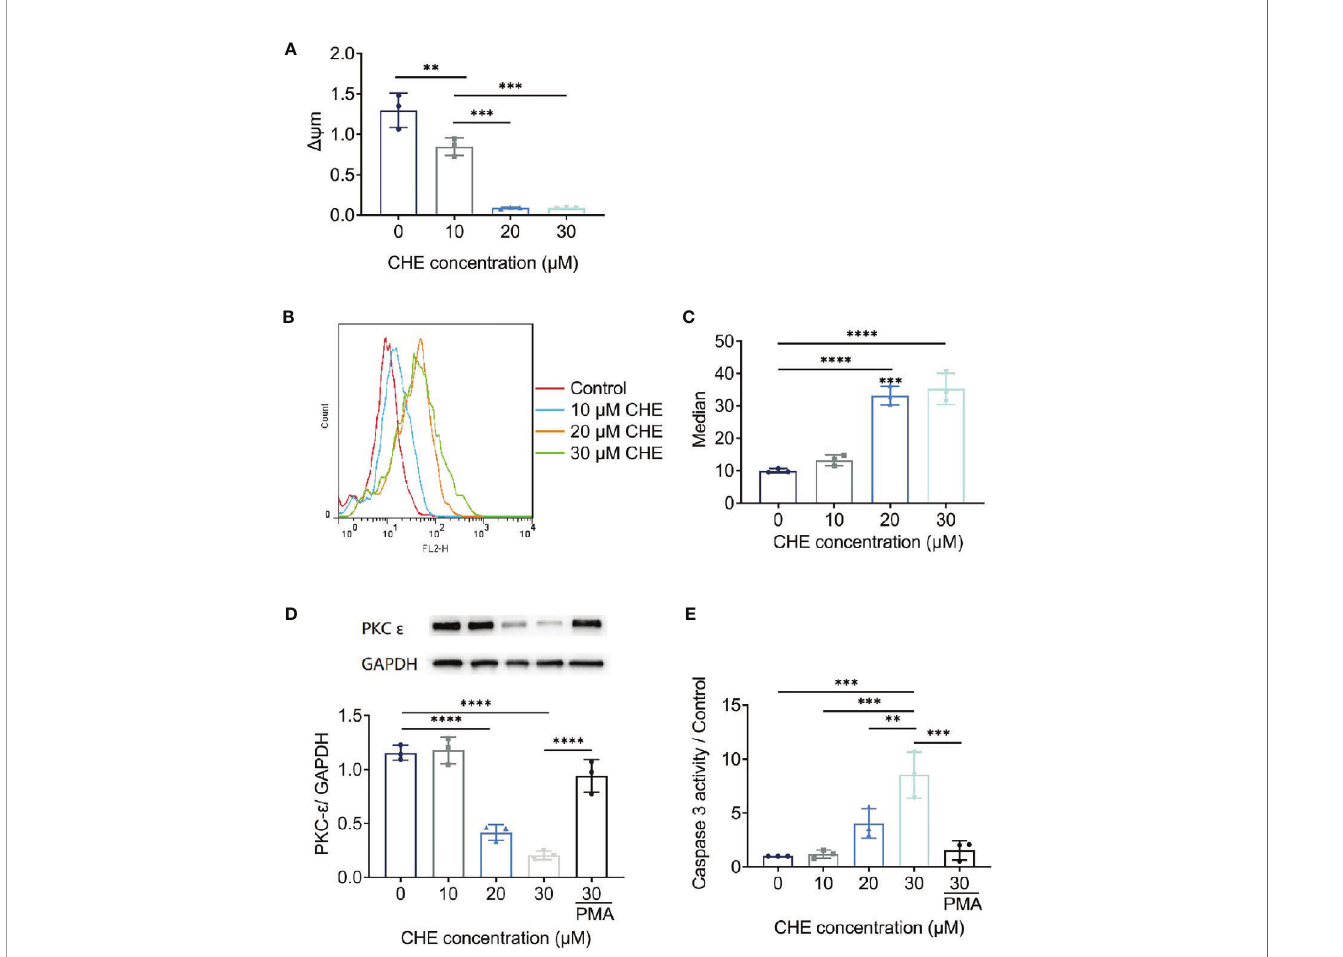
FIGURE 5 | The potential mechanism of HCC827 cell ’ s apoptosis induced by CHE. (A) The Dy m of HCC827 decreased after treatment of CHE. (B, C) ROS level in HCC827 cells after treatment of CHE. (D) CHE inhibited the expression of PKC- ϵ in HCC827 cells. (E) CHE increased of viability of caspase 3 in HCC827 cells. (****p < 0.0001, ***p < 0.001, **p <